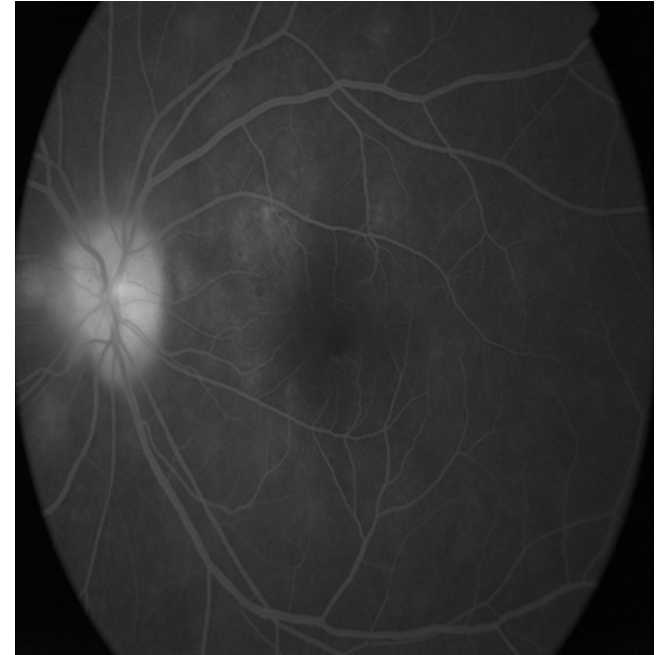
Figure 2: Fundus flourescein angiography of left eye depicting disc leakage